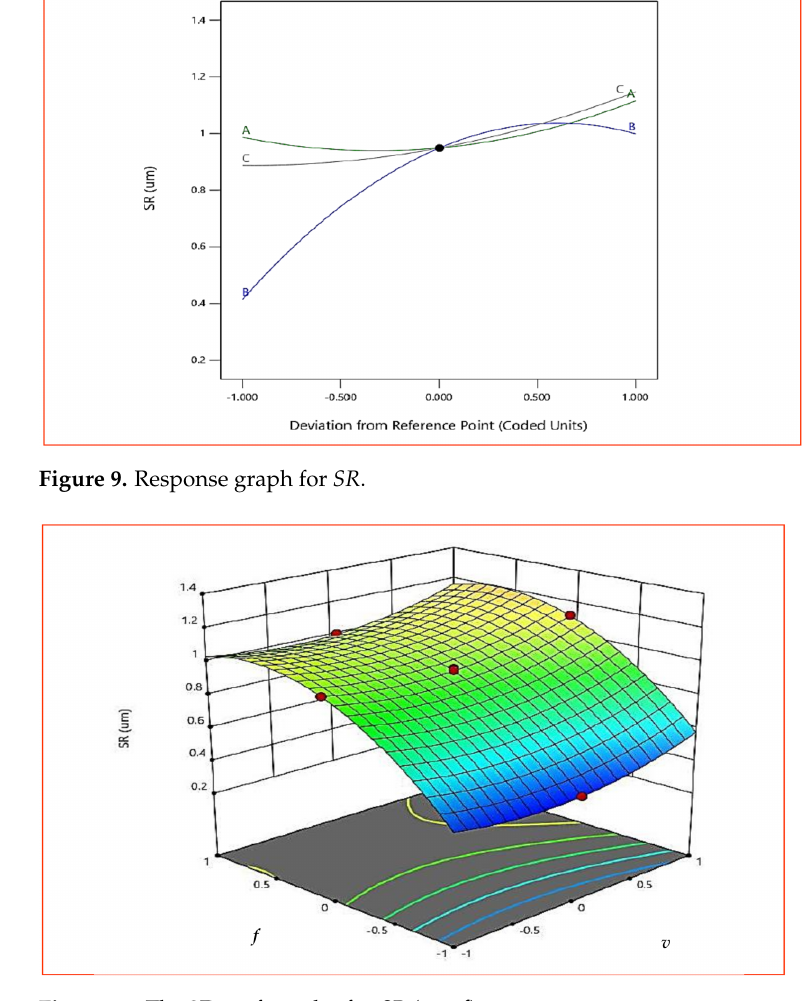
Figure 10. The 3D surface plot for SR ( v × f